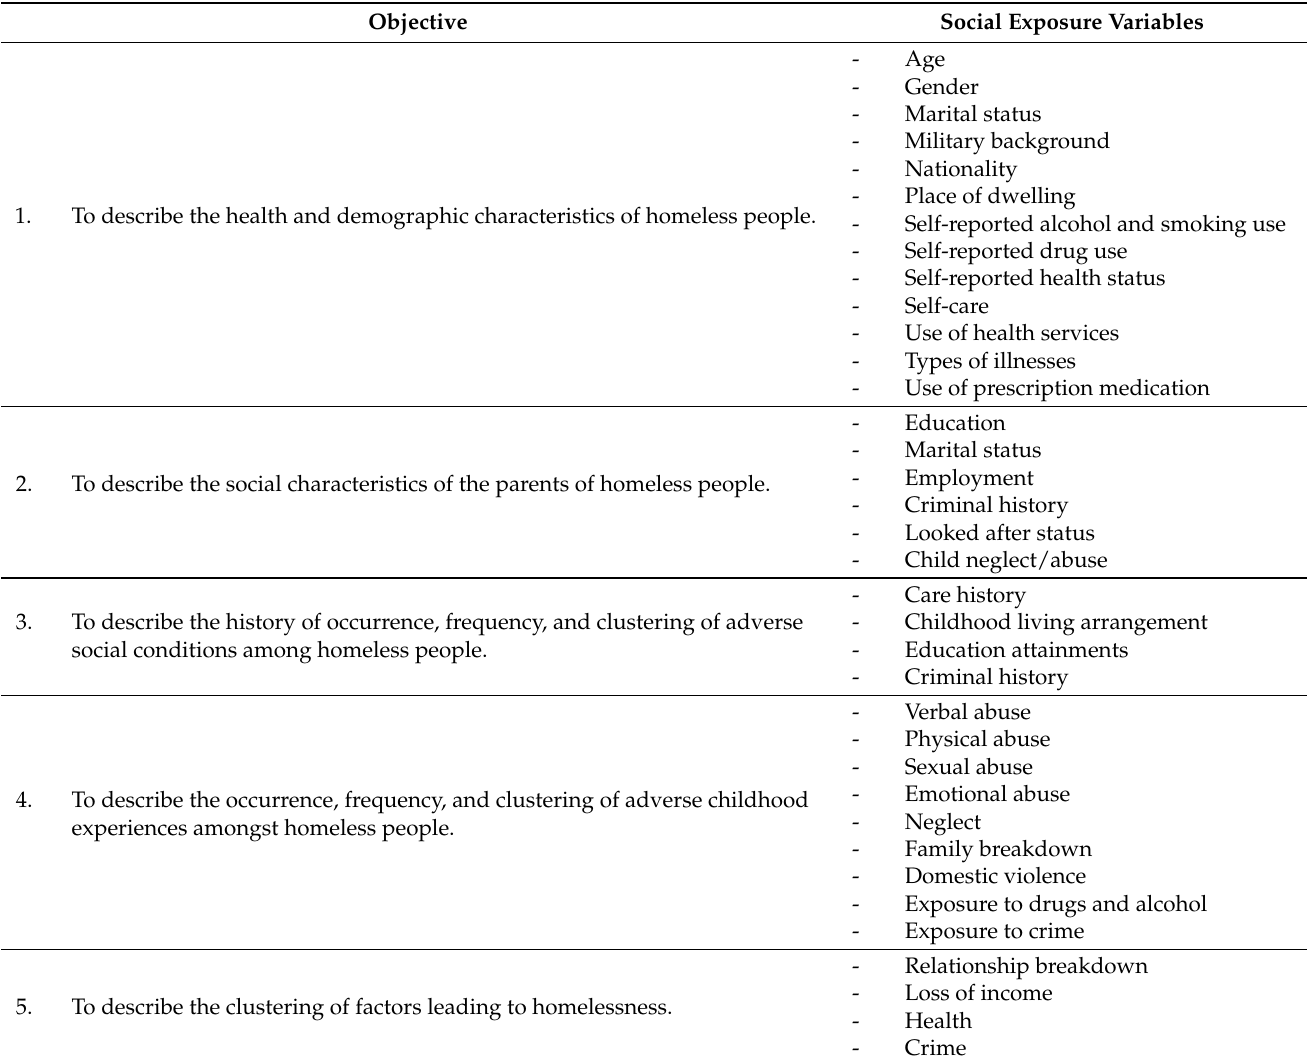
Table 1. Study objectives and corresponding